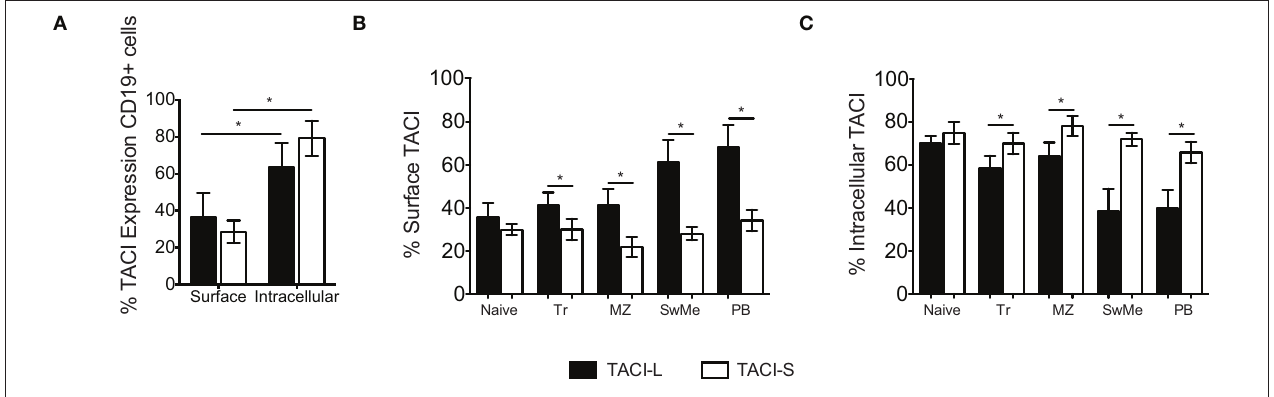
FIGURE 8 | (A) TACI isoforms are differentially expressed in B cell subpopulations. Surface and intracellular TACI isoforms frequency in freshly isolated peripheral blood CD19 + cells. Data shows the mean ± SEM of 4 independent experiments for 4 normal donors. * p < 0.05, two-tailed paired Student t -test. (B) Percent of expression of surface and intracellular (C) TACI isoforms in different B cell subpopulations isolated from blood of 4 donors: Naïve (IgD + CD27-), Transitional (Tr) (IgM + CD38 + ), Marginal Zone (MZ) (IgD + CD27 + ), Switched Memory (SwMe) (IgD-CD27 + ), and Plasmablasts (PB) (IgD-CD27 hi CD38 hi ). Data compile the results for 4 experiments. Data shows the mean ± SEM. * p < 0.05, two-tailed paired Student t -test.